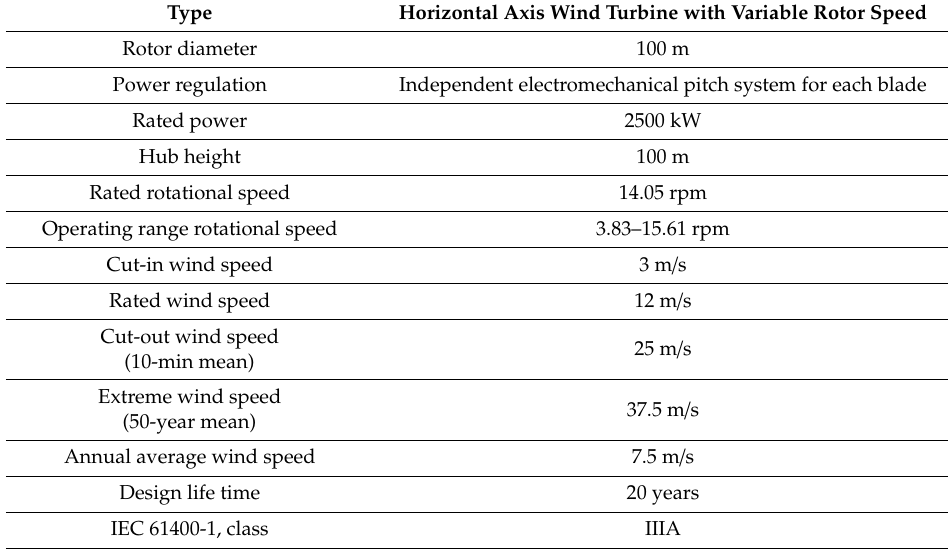
Table A1. Technical specifications of the GE 2.5 (MW) wind